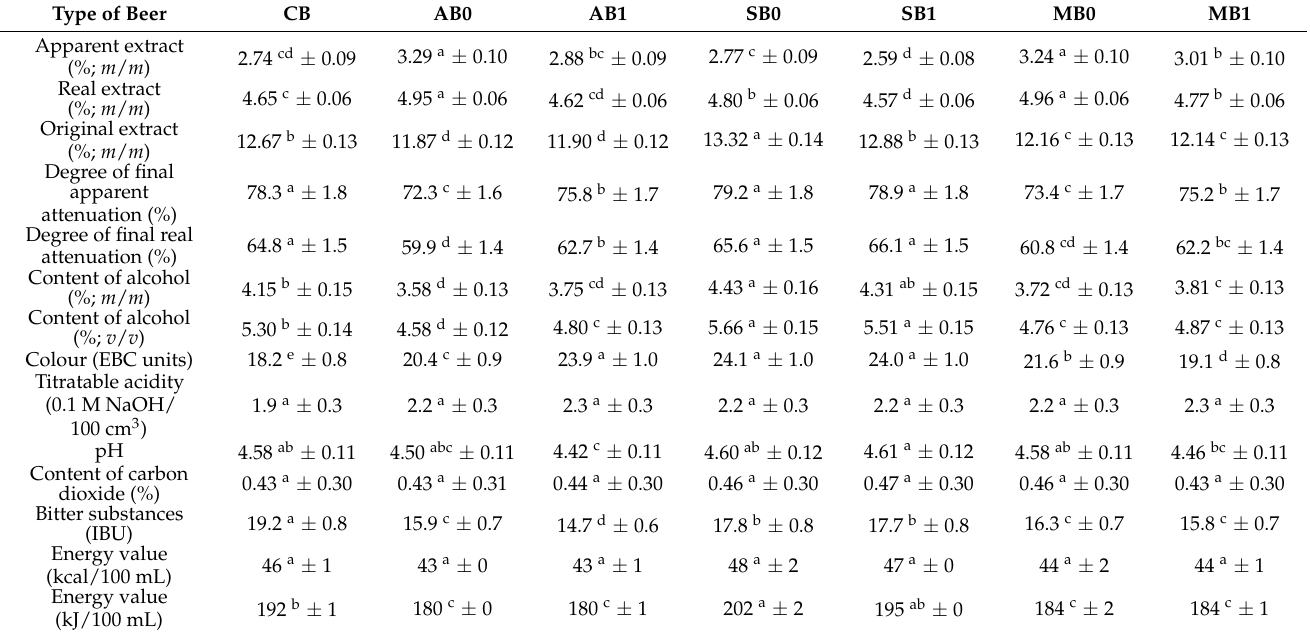
Table 1. Physicochemical analysis of the beers produced with an addition of the Saskatoon